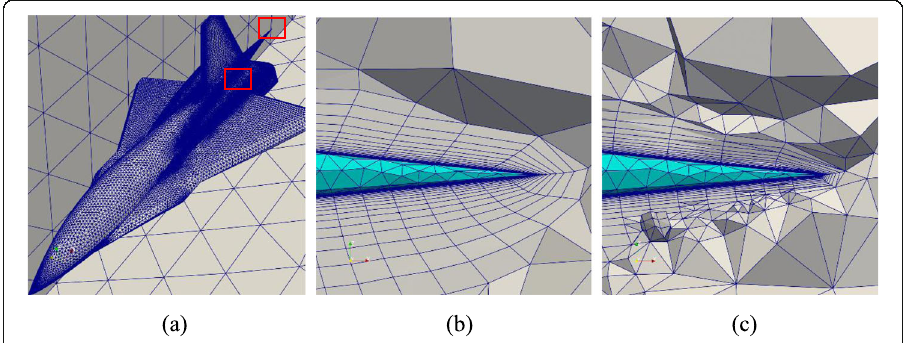
Fig. 12 Meshing results in the neighbourhood of one sharp convex corner. ( a ) Surface input. ( b ) Result